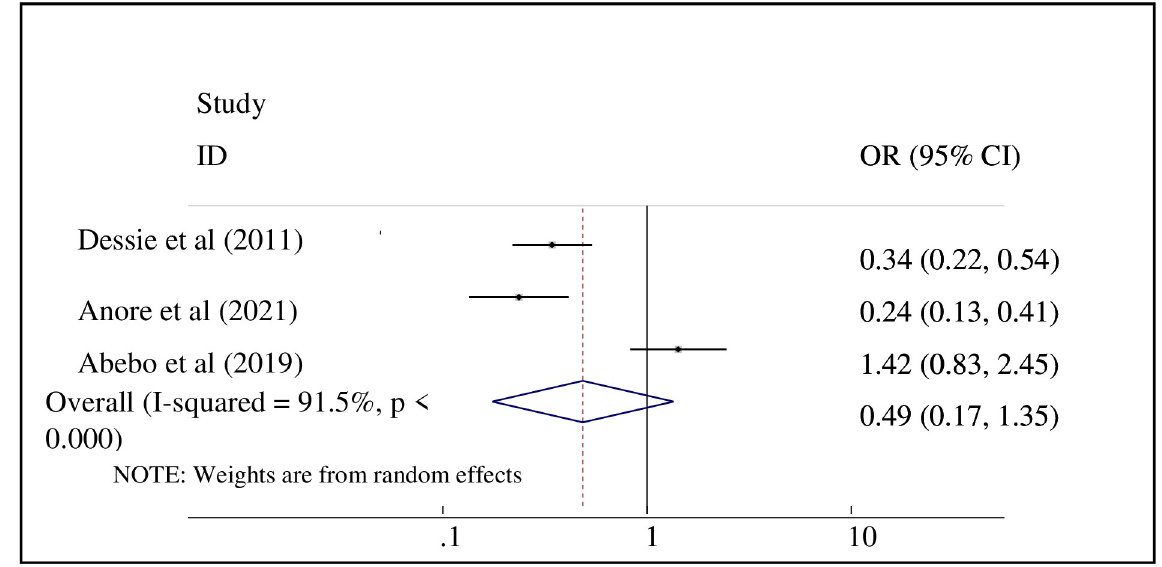
Fig 9. Forest plot showing the association between risky sexual practice and partner’s sero-status of PLWHA, Ethiopia.